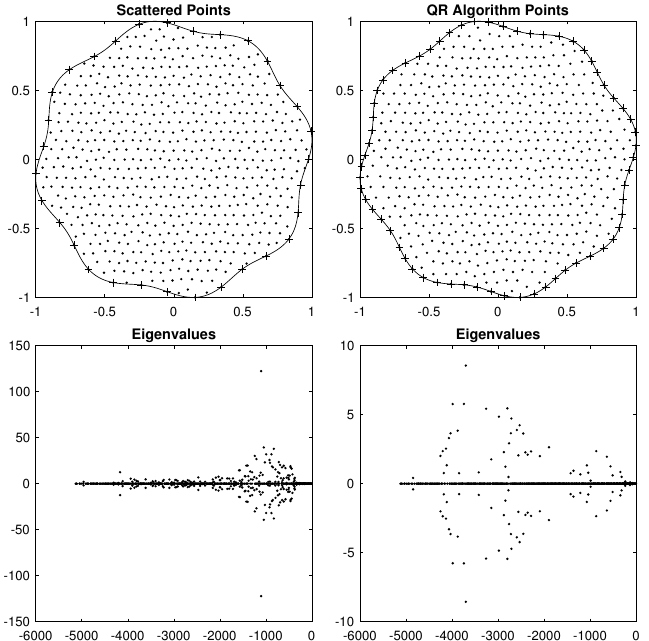
Figure 18. MCpQR boundary selection for scattered repel algorithm points on the bumped-disk region.